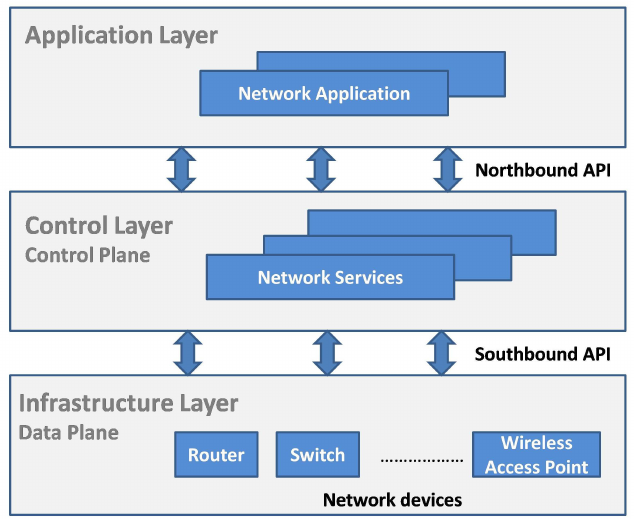
Figure 2. SDN layered